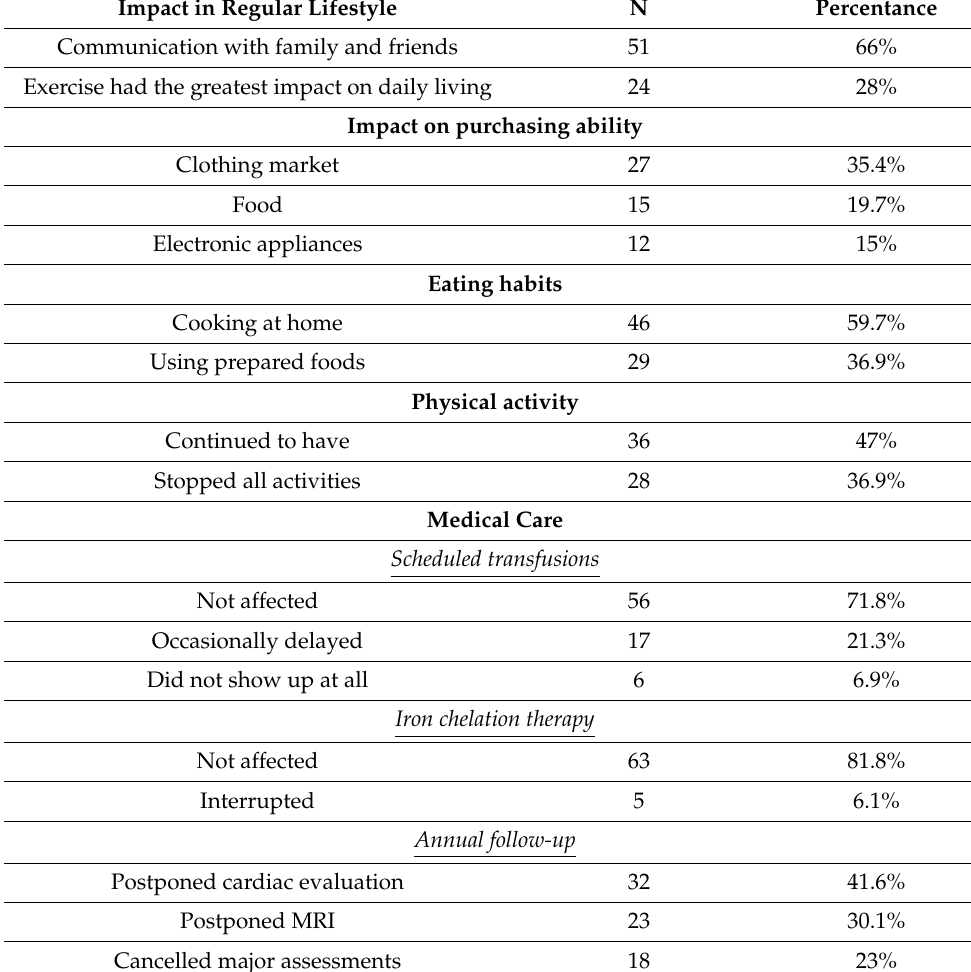
Table 1. Detailed data about the variables affected by the pandemic. Impact in Regular Lifestyle N Percentance Communication with family and